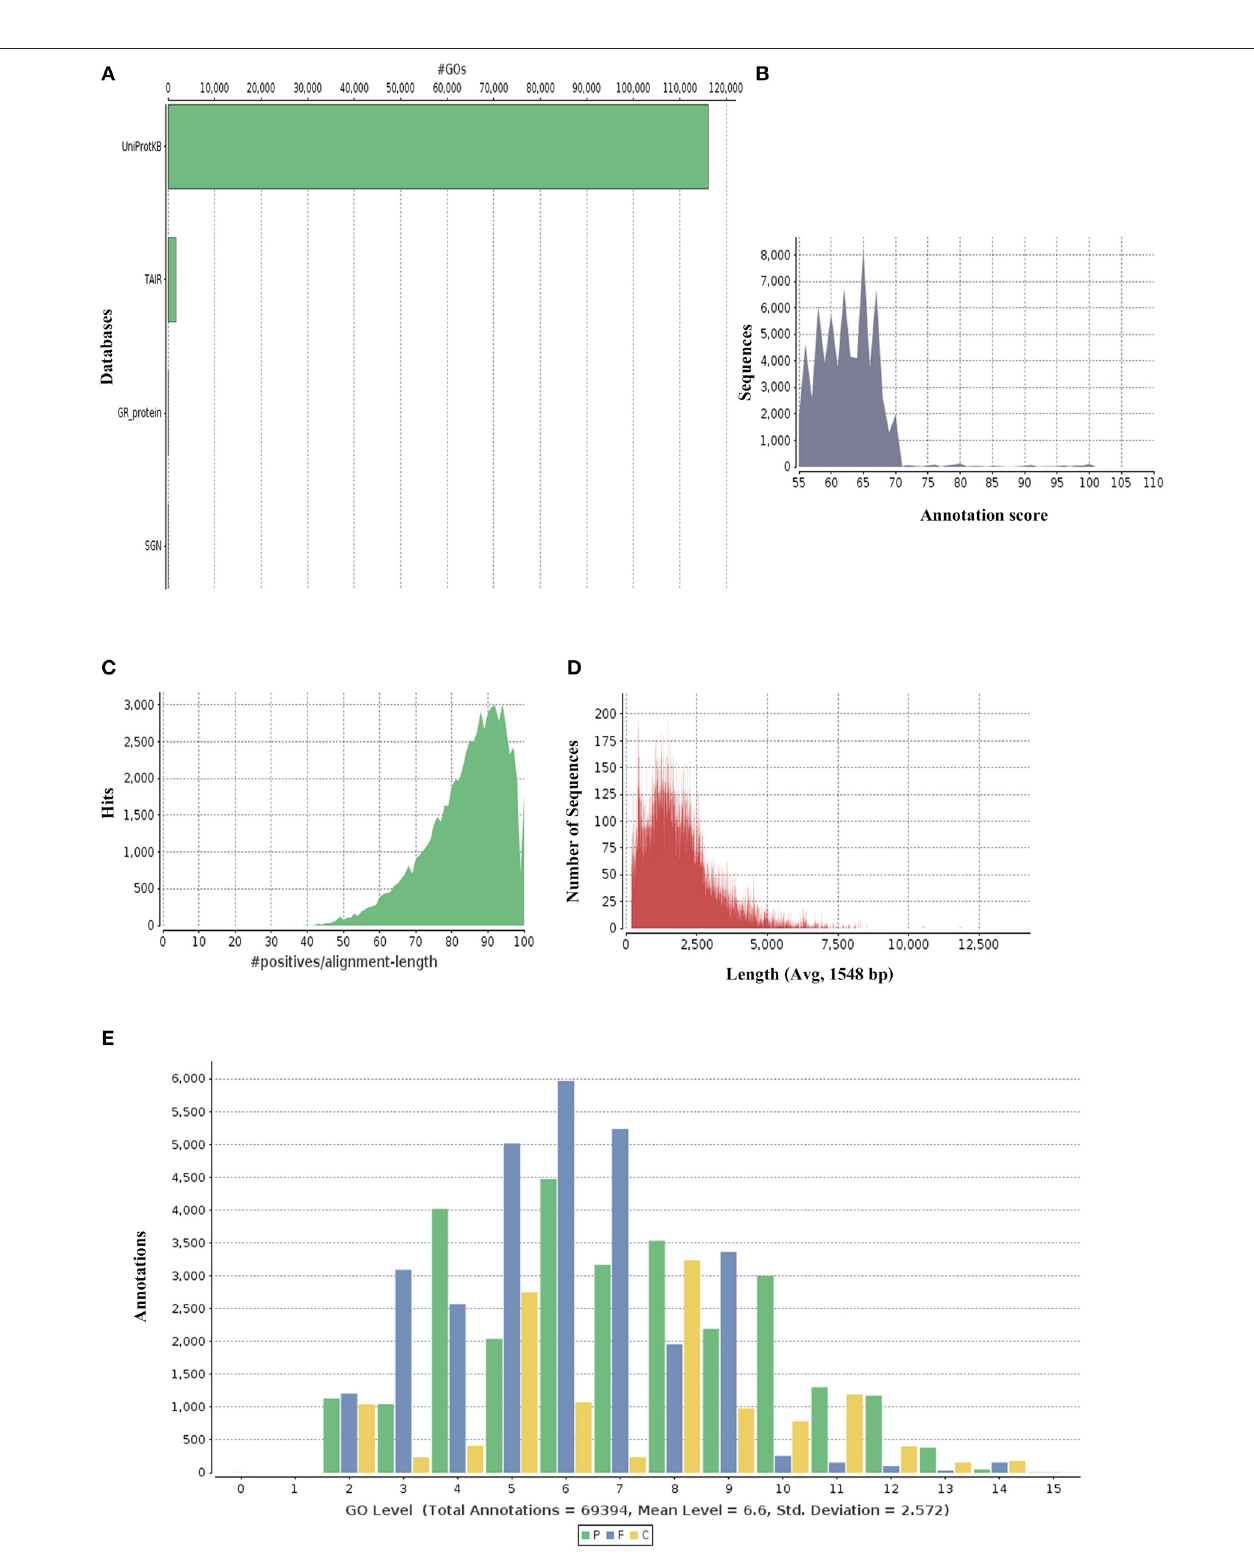
FIGURE 2 | Graphical representations of functional annotations in P. amarus leaf transcriptome. (A) Representation of mapping databases (UniprotKB, TAIR) sources. (B) Annotation score distribution of assembled unitranscripts. (C) Sequence similarity distribution graph. (D) Distribution of annotated sequences with length. (E) GO level distribution of annotated unitranscript sequences.